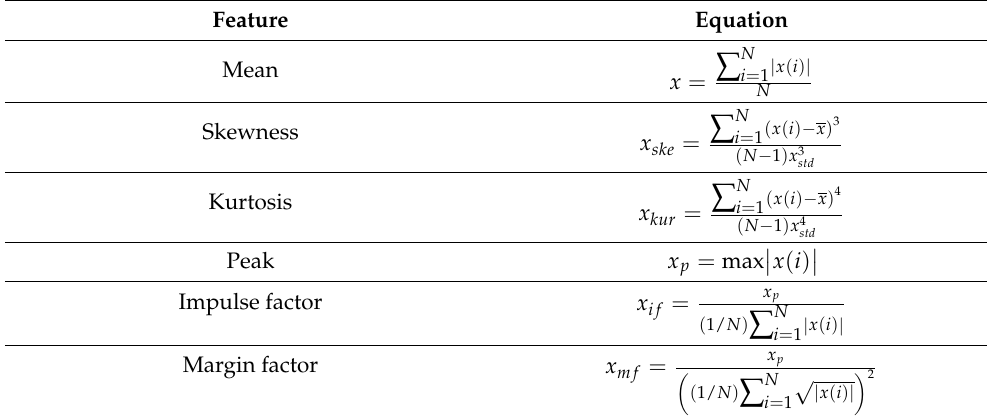
Table 1. Time-domain